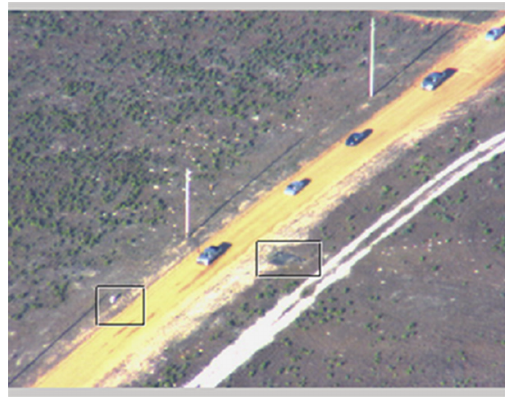
Figure 5: Image with